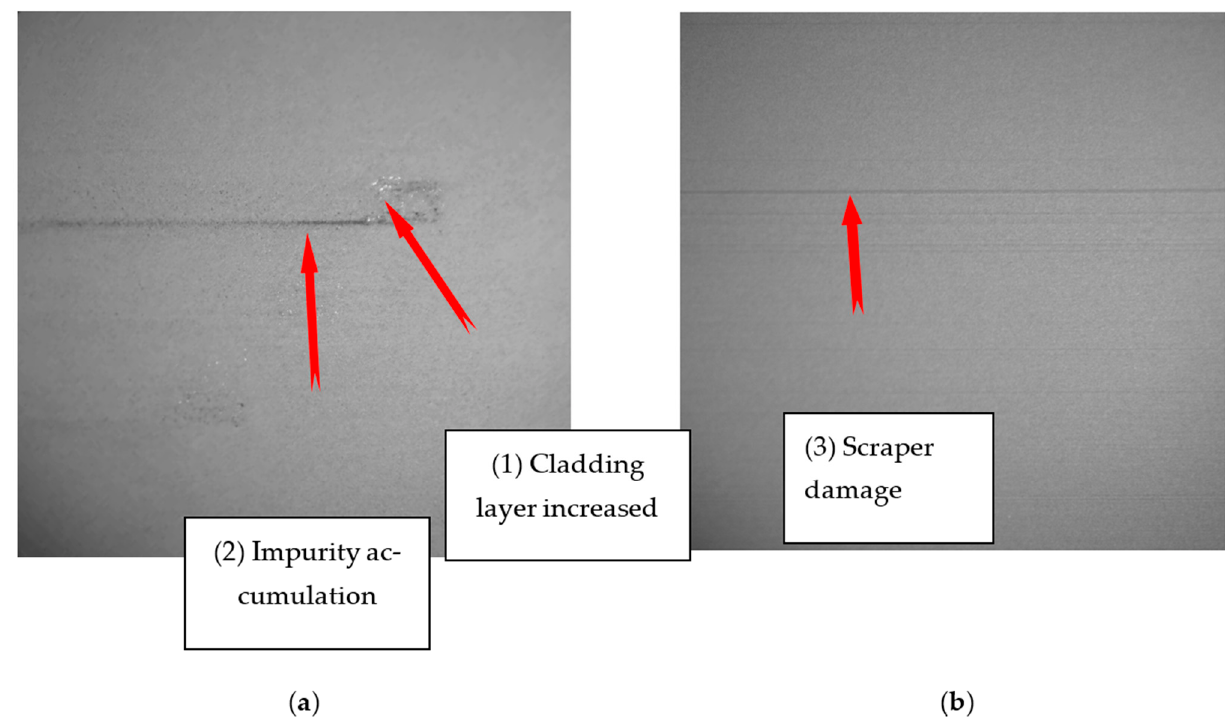
Figure 3. SLM powder spreading defect: ( a ) Defects of cladding (1) and impurity accumulation (2). ( b ) Scraper damage defects (3).